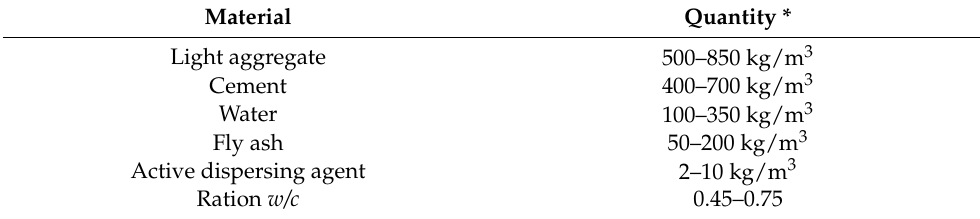
Table 11. Insulation refractory concrete formulation [61].